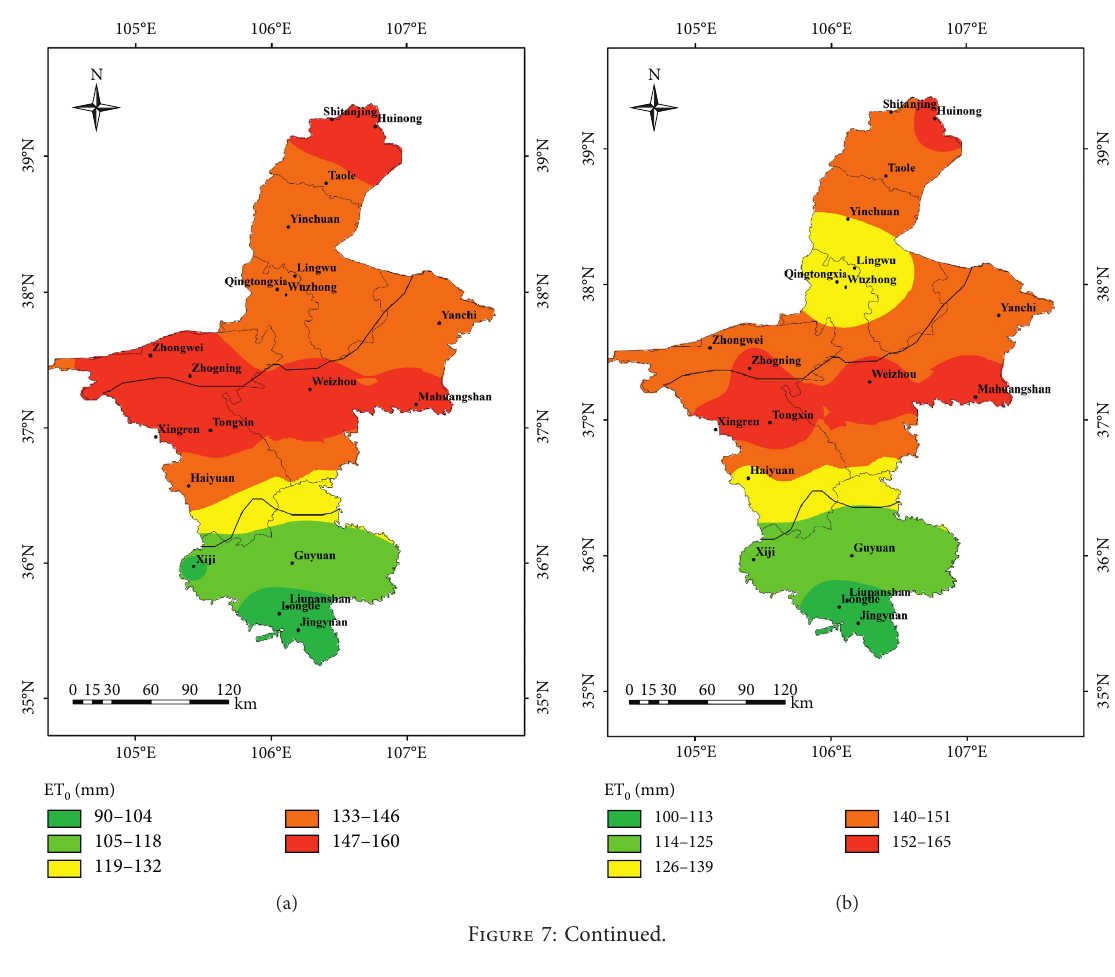
0 in Ningxia and each region.